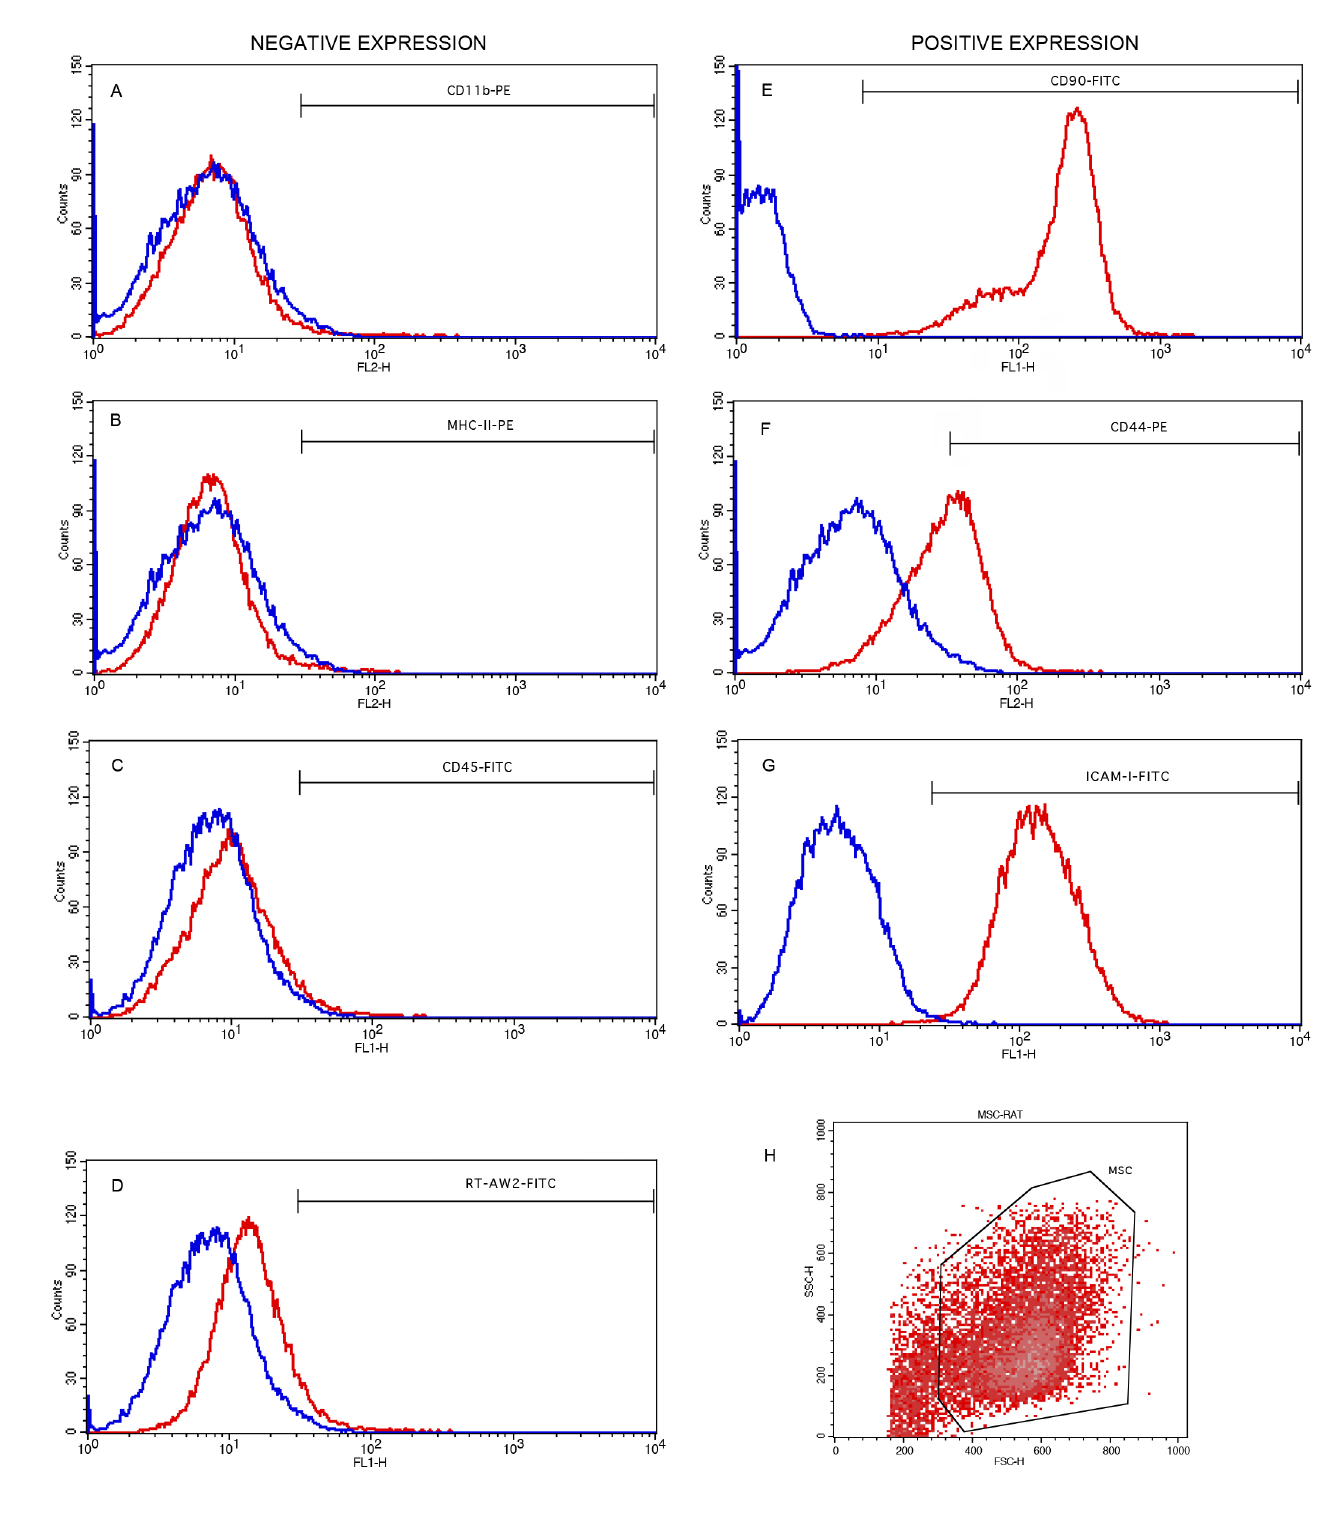
Figure 3. Flow cytometry analysis of mesenchymal stem cells characterized by surface markers. Blue line: negative markers; red line: positive markers. (A) CD11B, (B) MHC class II, (C) CD45, (D) RT1-Aw2, (E) CD90, (F) CD44, (G) ICAM1, and (H) gate of analyzed cell